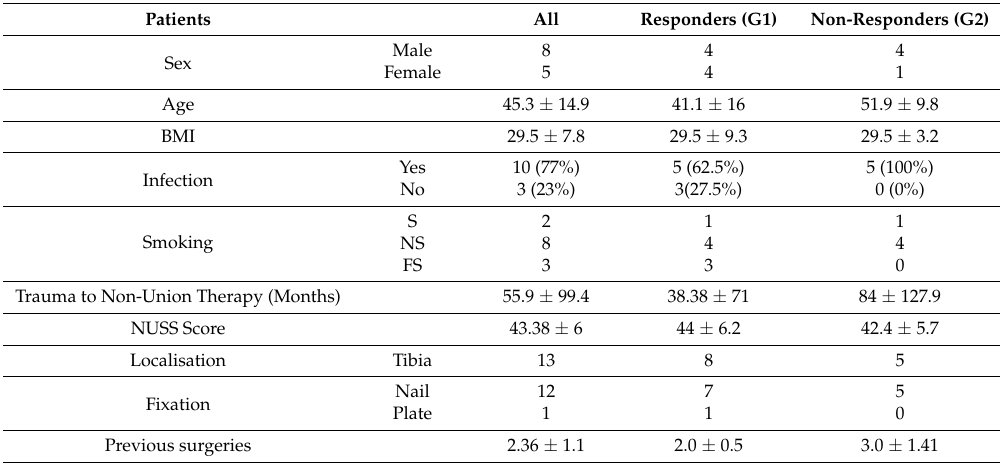
Table 1. Patient characteristics.